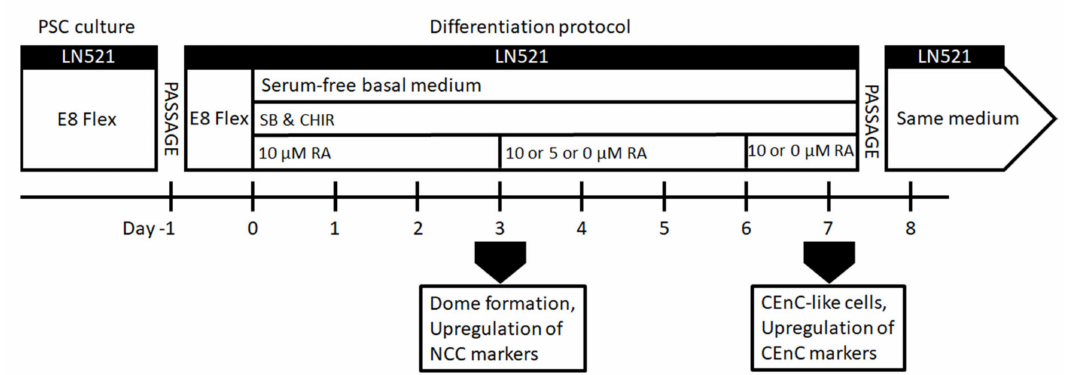
Figure 1. Schematic presentation of the human pluripotent stem cell (hPSC)-CEnC differentiation protocol. Abbrevia- tions: LN521 = human recombinant laminin 521, E8 Flex = Essential 8 Flex Medium, SB = activin/ bone morphogenetic (BMP)/transforming growth factor beta (TGF- β ) pathway inhibitor SB431542, CHIR = GSK-3 inhibitor and WNT pathway activator CHIR99021, RA = retinoic acid, NCC = neural crest cell and CEnC = corneal endothelial